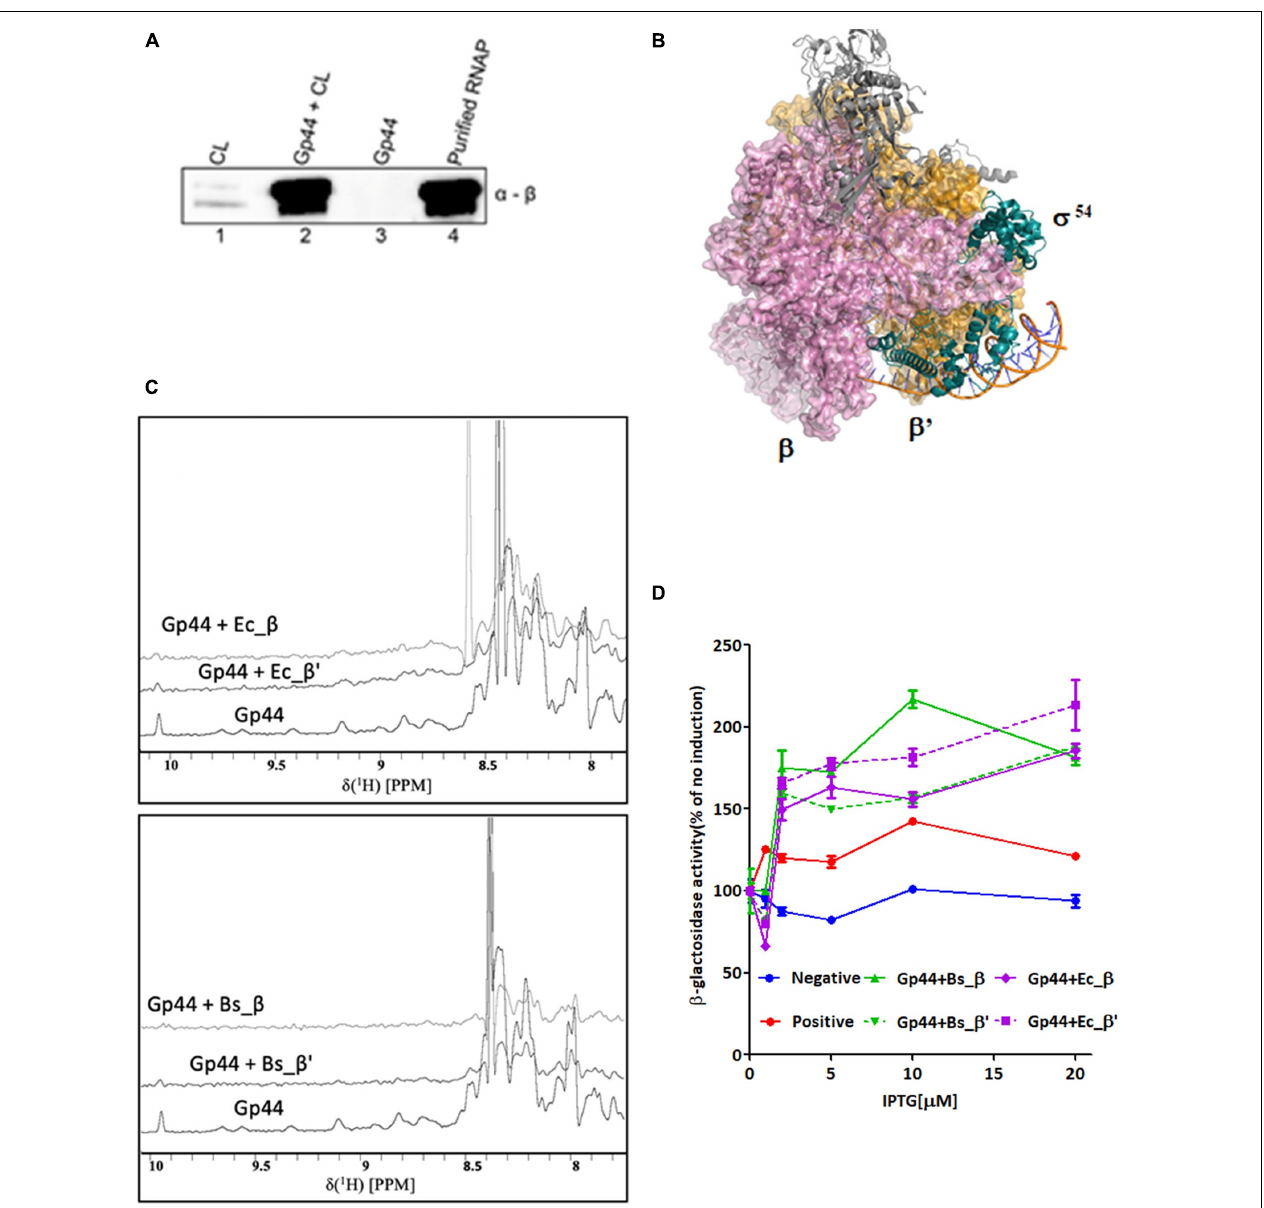
FIGURE 1 | Gp44 interacts with β and β (cid:48) subunits of B. subtilis and E. coli RNAP. (A) Images of SDS-PAGE gel (left panel) and immunoblotting with anti RNAP β subunit antibody (right panel) showing results of the pull-down assay with His-tagged Gp44 and whole-cell extracts (WCL) of B. subtilis. (B) Complex structure of RNAP- σ 54 holoenzyme initial transcribing complex in which σ 54 interacts with RNAP via β and β (cid:48) subunits (PDB ID: 6GFW. σ 54 , β and β (cid:48) subunits are labeled respectively.) (C) 1 H NMR spectra showing peak broadening effect when adding β and β (cid:48) subunits of B. subtilis and E. coli to Gp44. (D) BTH assay shows Gp44 interacts with β and β (cid:48) subunits of E. coli and B. subtilis